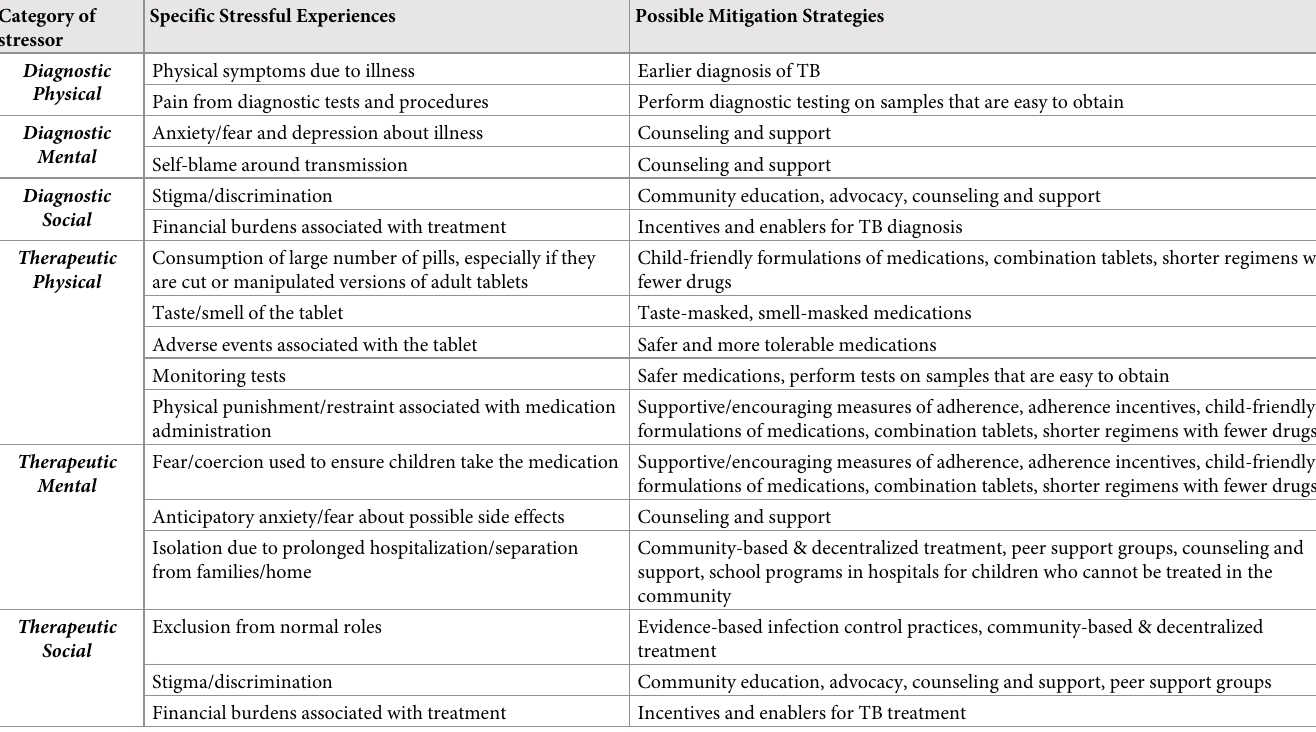
Table 2. Summary of pediatric DR-TB stressful experiences and possible approaches to address